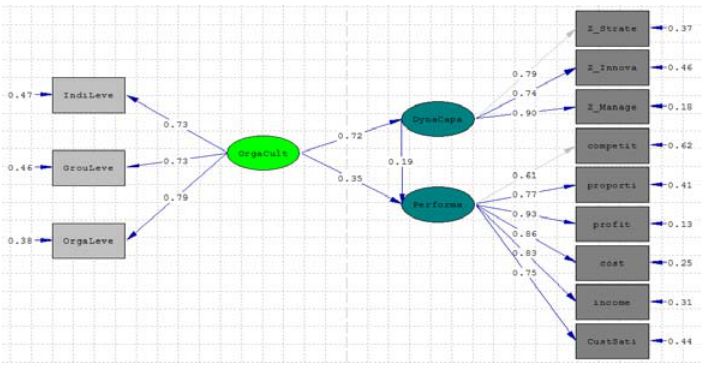
Fig. 3. The results of standard coefficients of the implementation of structural equation modeling